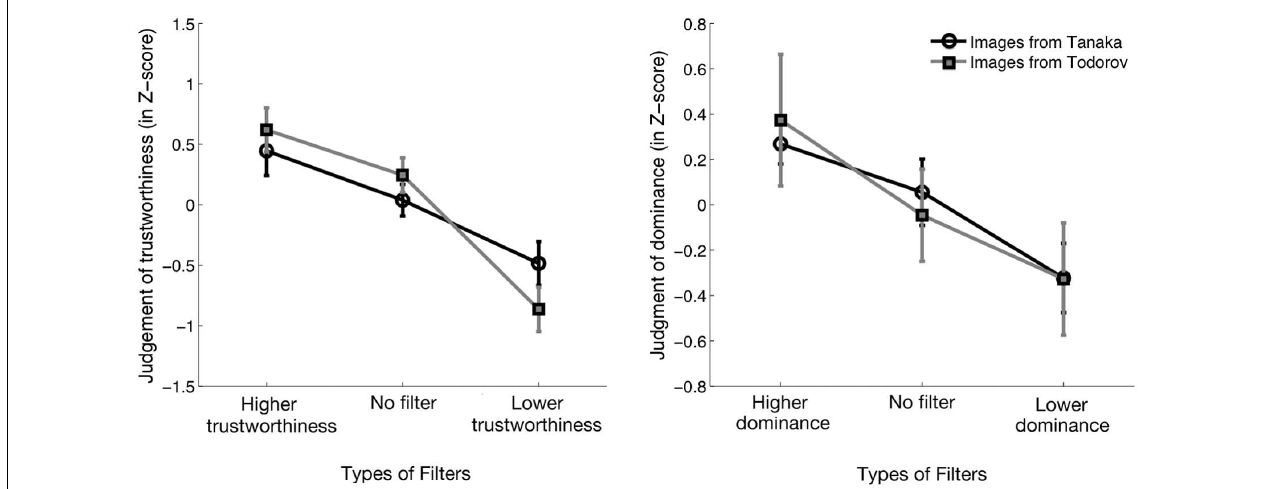
FIGURE 7 |Average normalized judgments according to different conditions of filtering (pro-[trait], neutral, anti-[trait]) in function of the two databases of